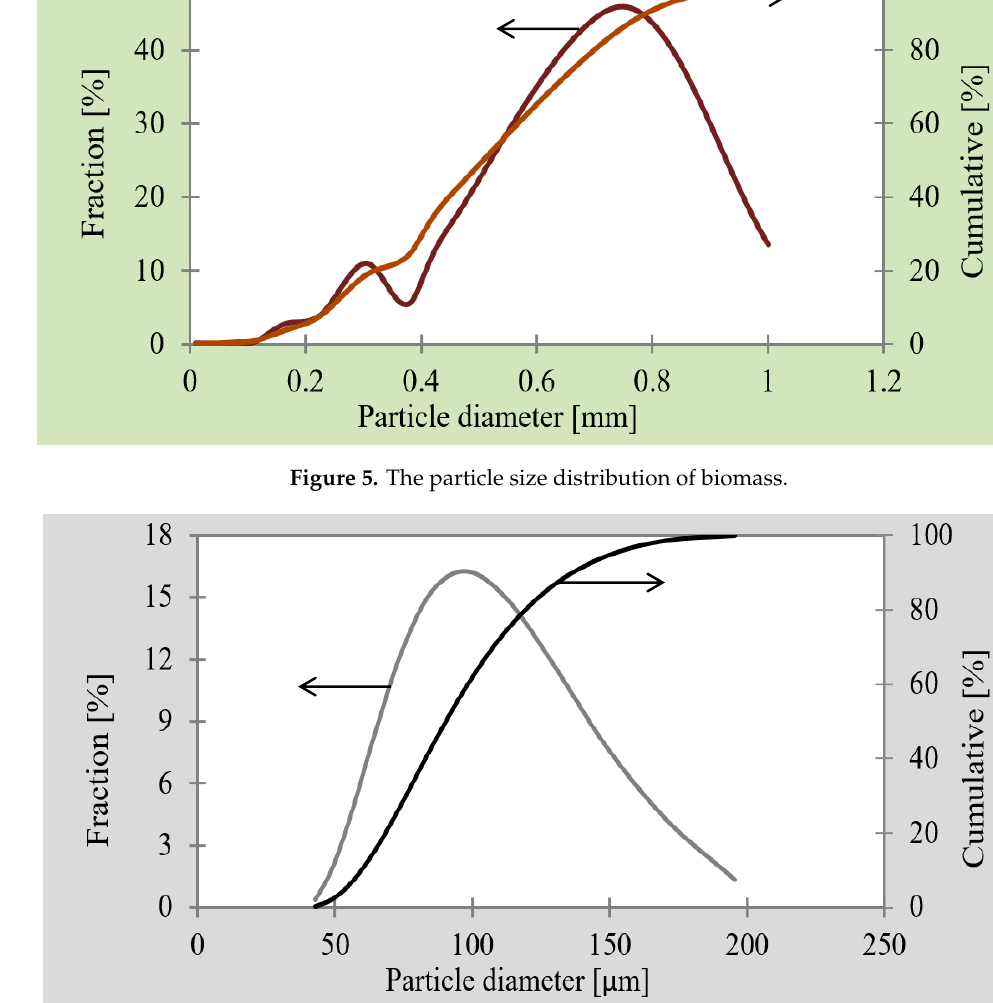
Figure 6. The particle size distribution of hard coal.